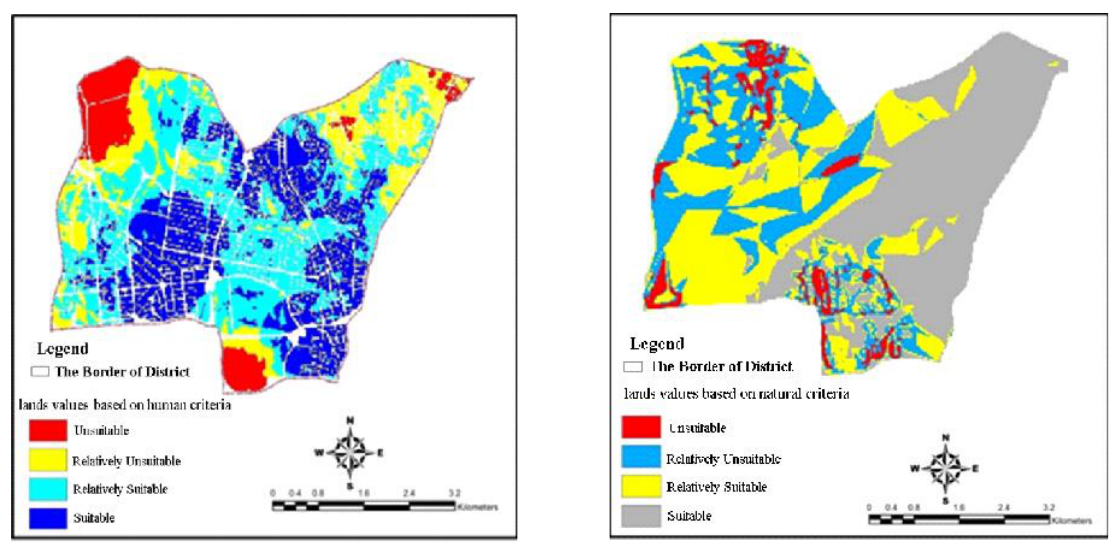
Fig. 17: Lands values based on human criteria Fig. 18: Lands values based on natural criteria